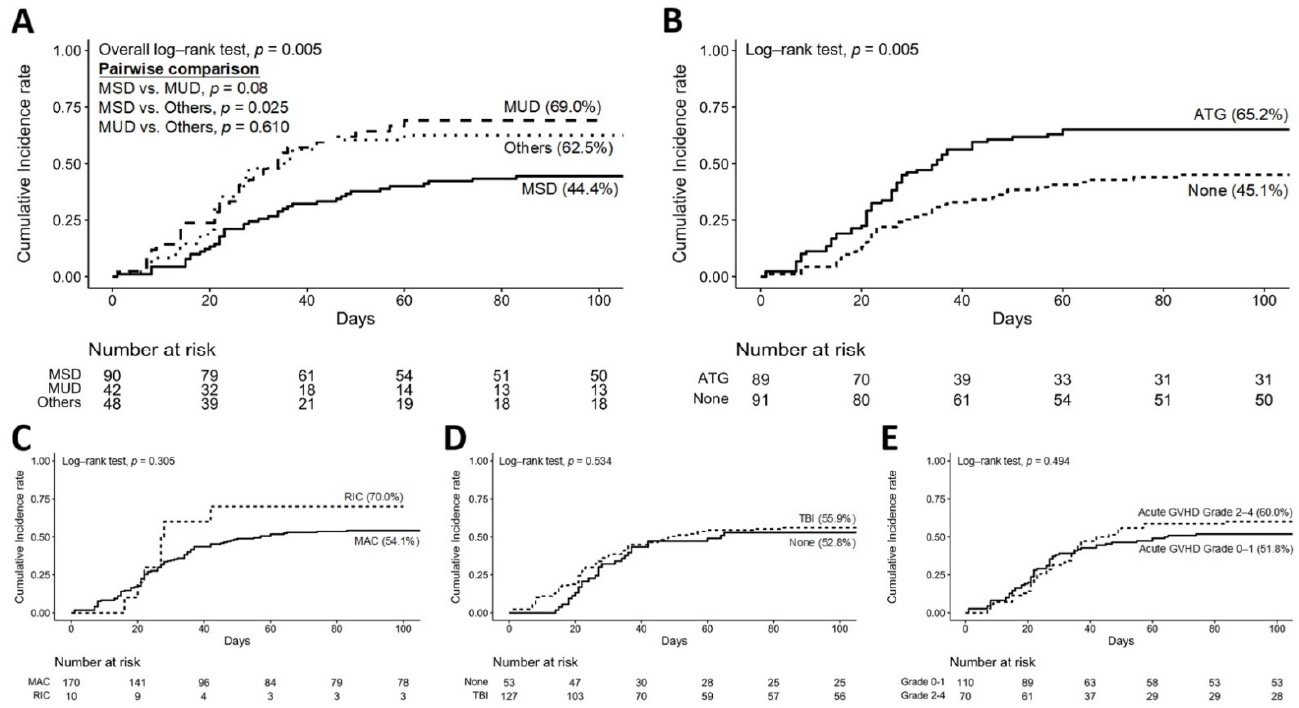
Figure 1. Cumulative incidence rate of CMV reactivation within 100 days after transplantation. ( A ) different donor origins, ( B ) the usage of ATG or not, ( C ) different intensity of conditioning regimen, ( D ) the usage of TBI or not, and ( E ) different acute GVHD grades